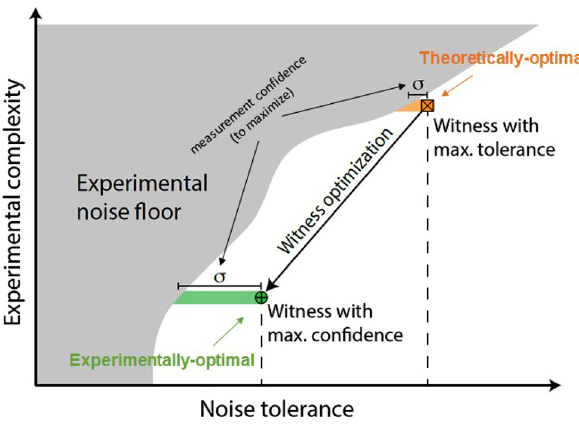
Figure 7: Complexity of the measurement settings versus the noise tolerance of the witness. A theoretically optimal witness (orange square) has the highest noise tolerance, at the cost of complex measurement settings, which increase the experimental noise floor (grey area). An experimentally optimal witness (green circle) has a lower noise tolerance, but requires less complex measurement settings, which makes the experimental noise floor decrease. The goal is to maximize the measurement confidence σ (shaded orange and green area) with which a negative witness expectation value is measured. Adapted from